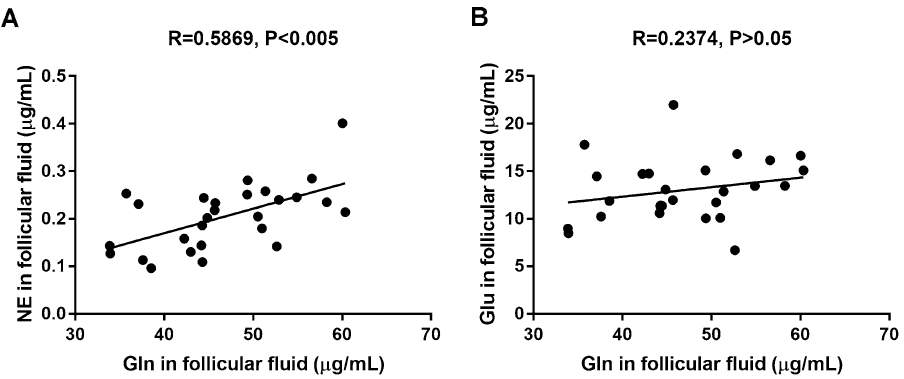
Figure 1. Correlation analysis of neurotransmitter concentrations in human follicular fluid on the day of oocyte retrieval. ( A ) A positive correlation between the concentration of glutamine (Gln) and norepinephrine (NE) in follicular fluid (n = 27, R = 0.5869, P < 0.005). ( B ) There was no correlation between the Gln and Glutamate (Glu) concentrations in the follicular fluid (n = 27, R = 0.2374, P >